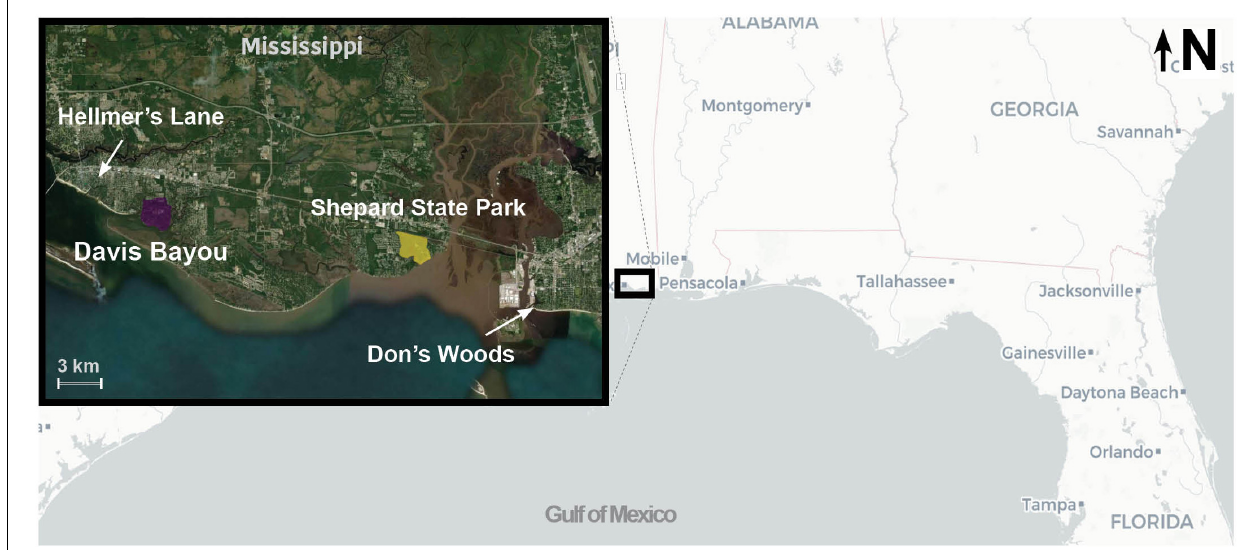
FIGURE 1 | Map of coastal Mississippi with paired study sites in small forested habitat patches [Hellmer’s Lane (HEL), Don’s Woods (DON)] and large contiguous forested areas [Davis Bayou area of the Gulf Islands National Seashore (DAV), Shepard State Park